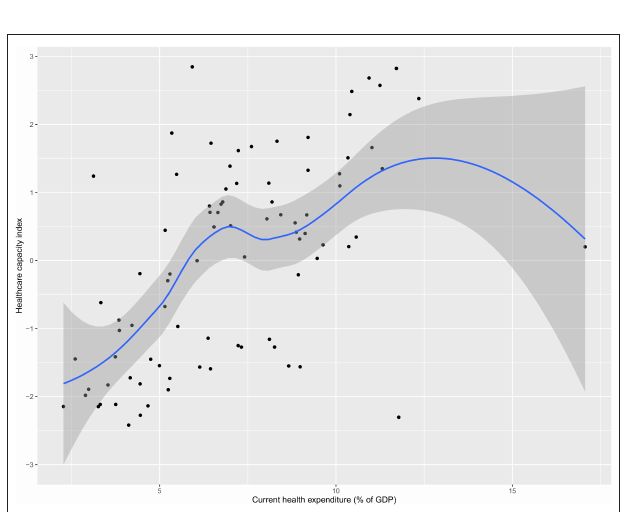
FIGURE 3 | Health expenditure and health capacity index (LOESS) plot.